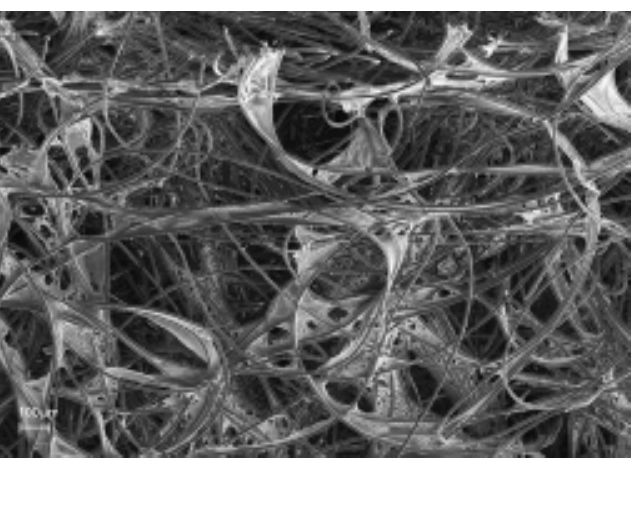
Example of a biodegradable scaffold (PGA/P4HB) before seeding.